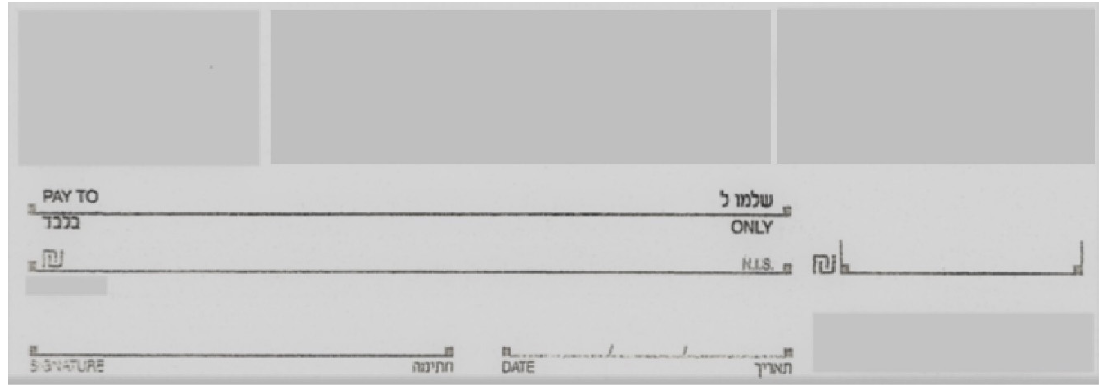
Figure 1. The fill-in-a-check task. The illustration shows the check format participants were required to fill